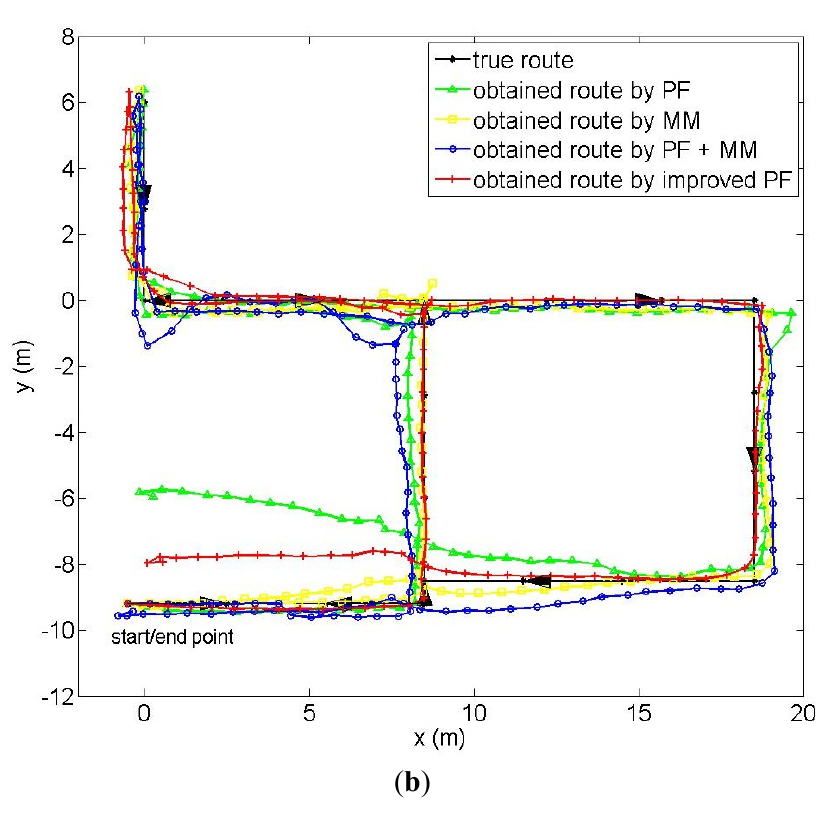
Table 1. Average (Avg) error for each trial (route 1).